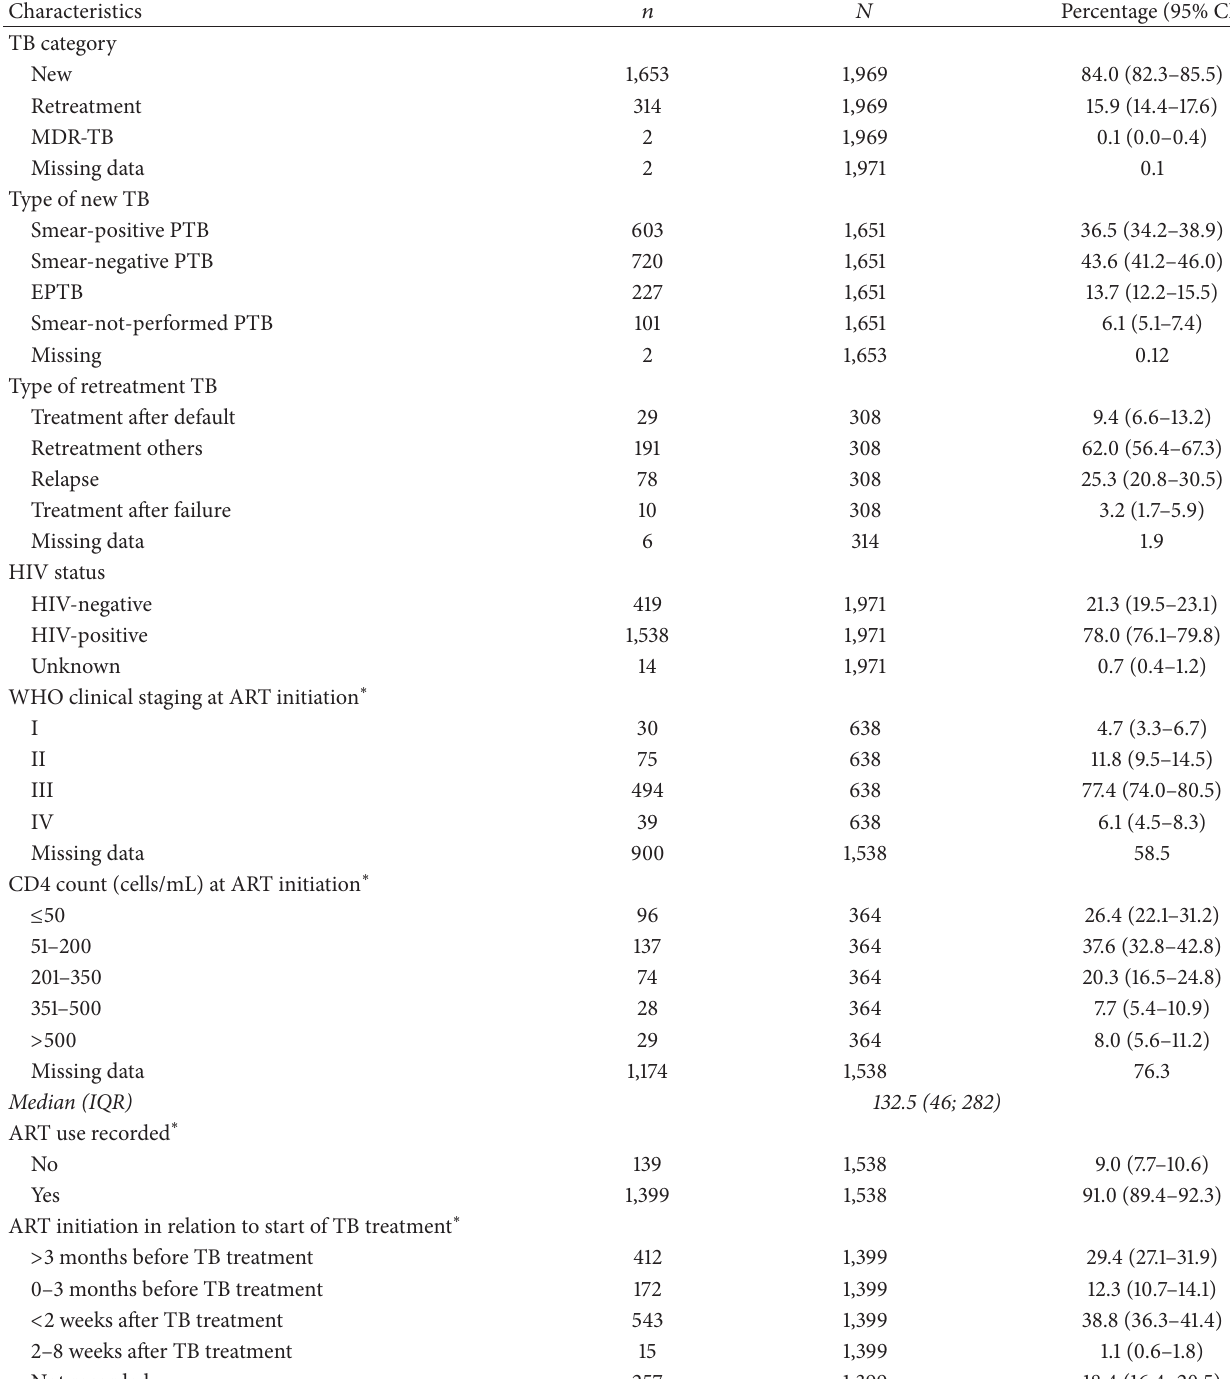
Table 2: Clinical characteristics of TB patients in southern Zimbabwe,